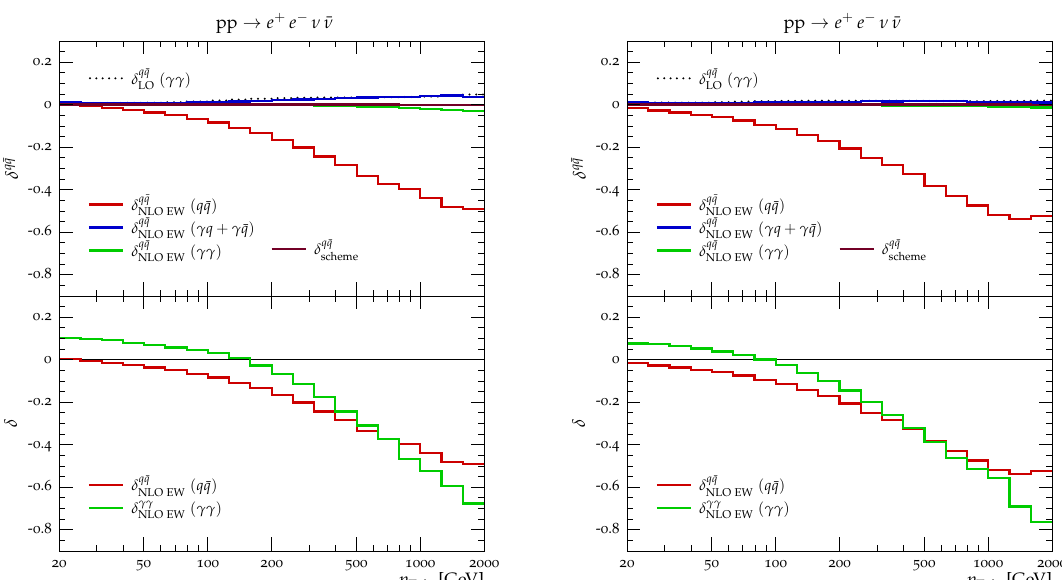
Figure 25 . Relative corrections in the transverse momentum of the leading and subleading lepton, p T ;‘ and p T ;‘ , for pp e + e (cid:0) (cid:23) (cid:22) (cid:23) at 13 TeV. Details as in (cid:12)gure 23. 1 2 !